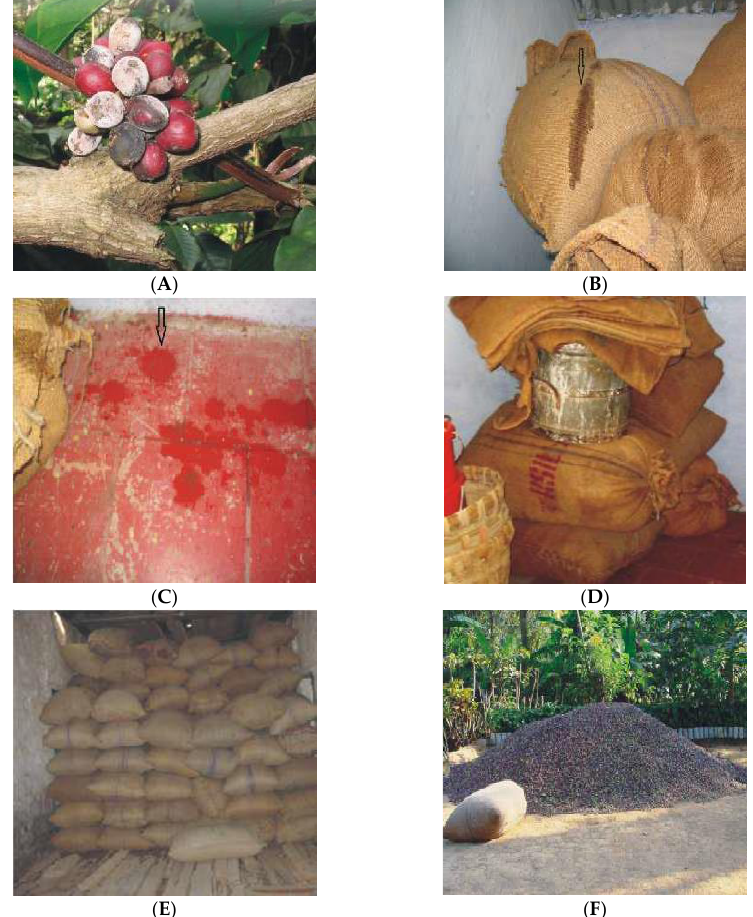
Figure 4. Various stages of coffee processing supporting the development of ochratoxigenic fungi: ( A ) Presence of Aspergilli on ripe coffee fruits; ( B ) rewetting of dried coffee stored in juta packages; ( C ) dampness of the storage floor due to moisture infiltration; ( D ) improper storage of packages on a farm without isolation from the adjacent walls. Infiltration of moisture from rooftops that wet the stored packaged coffee; ( E ) too heavily packed storage rooms at estate level; ( F ) poor drying surface on compacted soil.